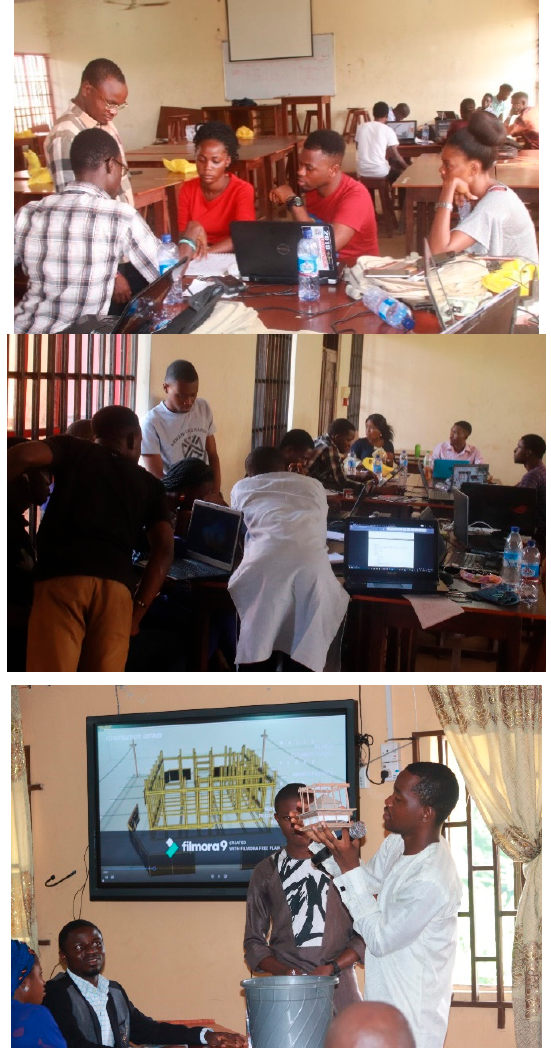
Figure 4. Workshop participants work in their groups (top images); public presentation of proposals on the final day (images below).